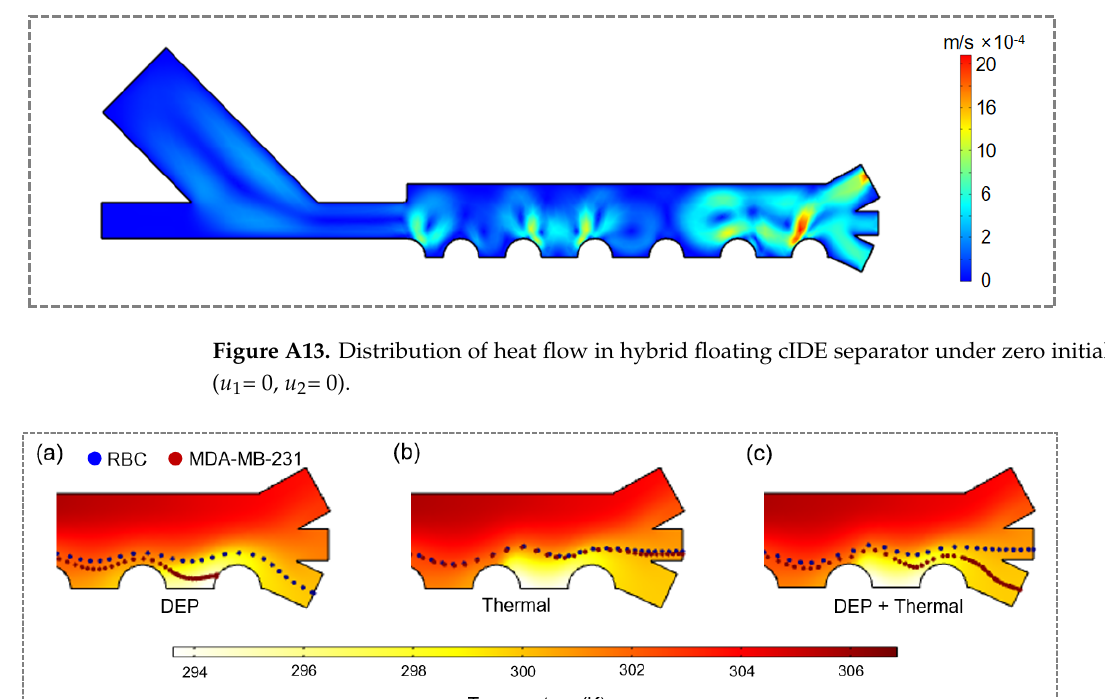
Figure A12. The dependence of Re[𝐾(𝜔)] of cells (RBC, WBC, CTC) on frequency at medium con- ductivity of 𝜎 (cid:3040) = 0.002 S/m. All calculations are based on Equation (5) in the manuscript.